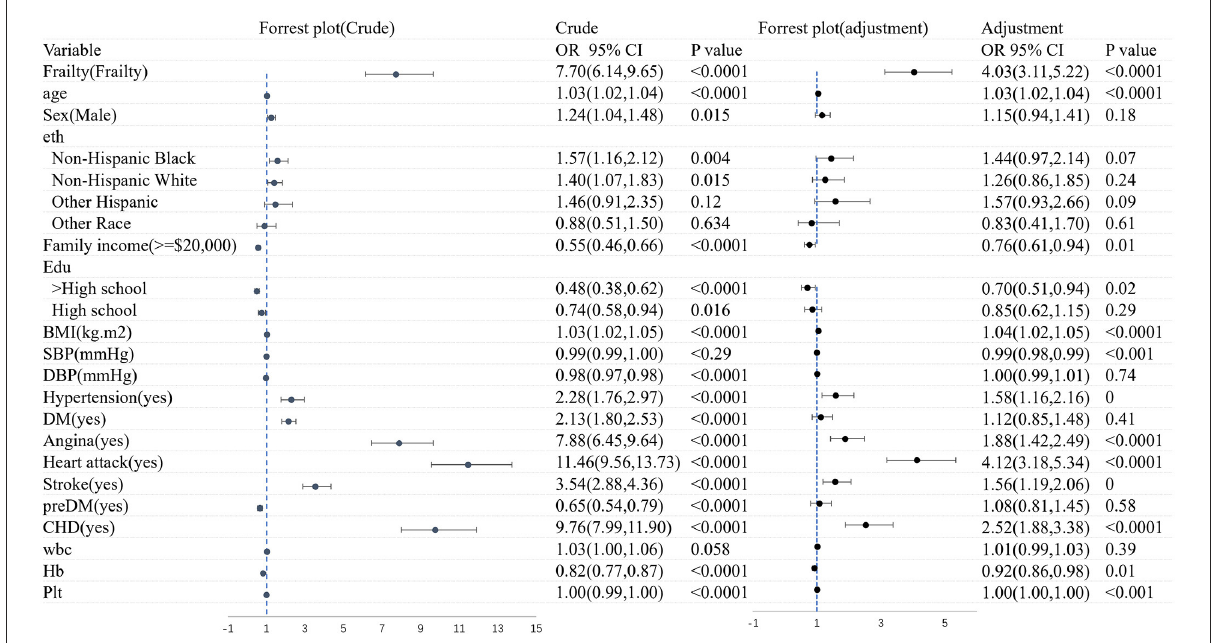
FIGURE4 The logistic regression analysis of CHF before and after adjustments for the